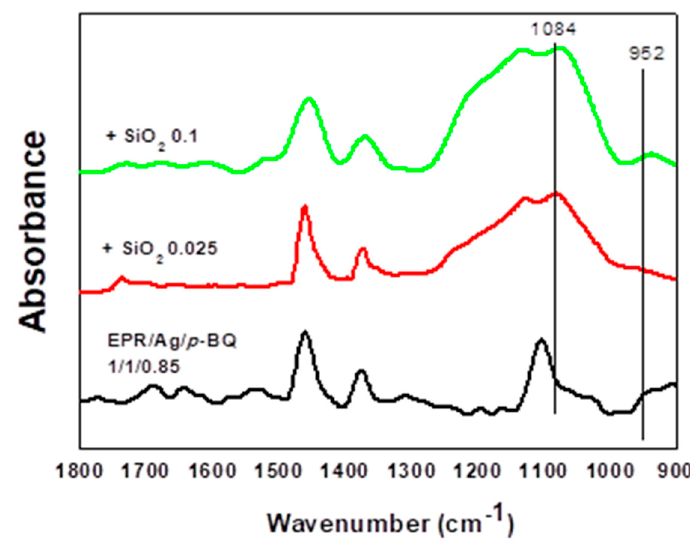
Figure 5. FT-IR spectra of 1 / 1 / 0.85EPR / Ag nanoparticles / p -BQ composites with varying contents of silica nanoparticles.